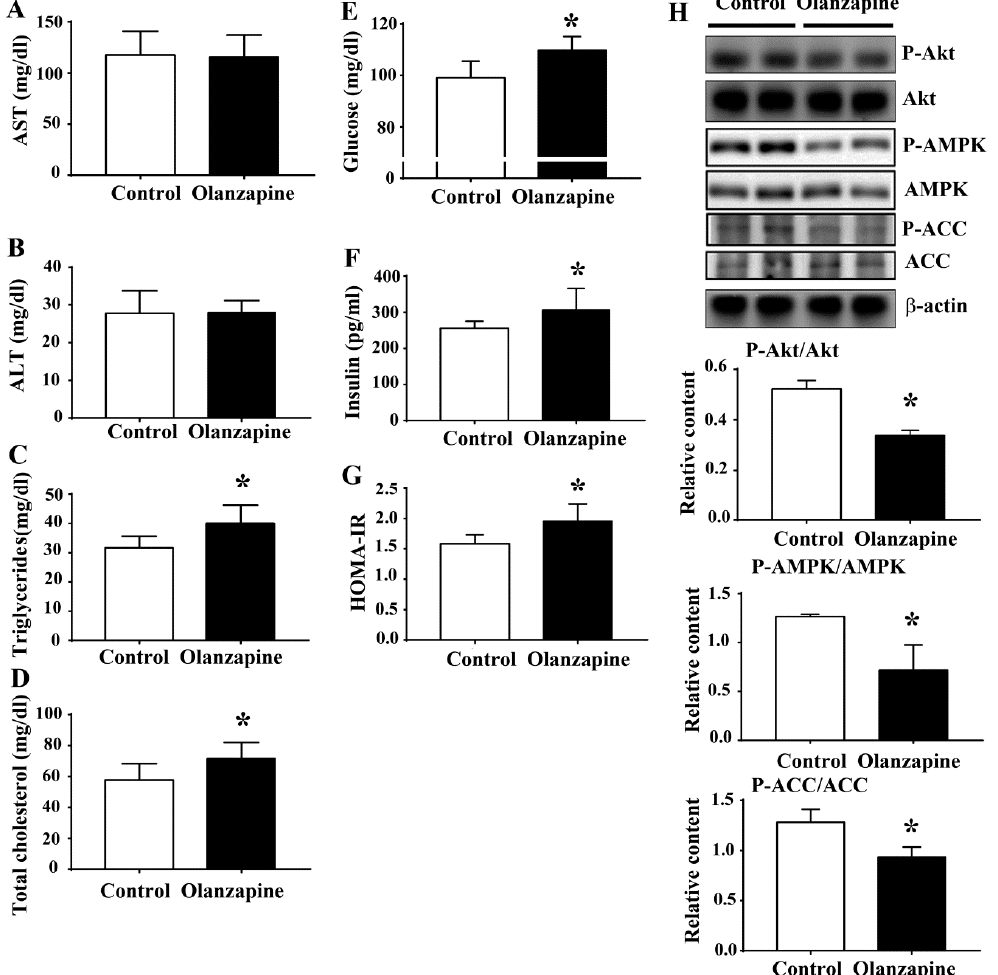
Figure 2. Olanzapine caused a metabolic disturbance. At the end of the experiments, serum samples were subjected to analyses for the measurement of aspartate aminotransferase (AST) ( A ), alanine aminotransferase (ALT) ( B ), triglycerides ( C ), total cholesterol ( D ), fasting glucose ( E ), and insulin ( F ). The value of Homeostasis Model Assessment-Insulin Resistance (HOMA-IR) is depicted in ( G ). ( H ) Proteins were extracted from the excised liver tissues and subjected to Western blotting with indicated antibodies. Representative blots are shown, and the quantitative data are depicted. * p < 0.05 vs. control, n = 10.